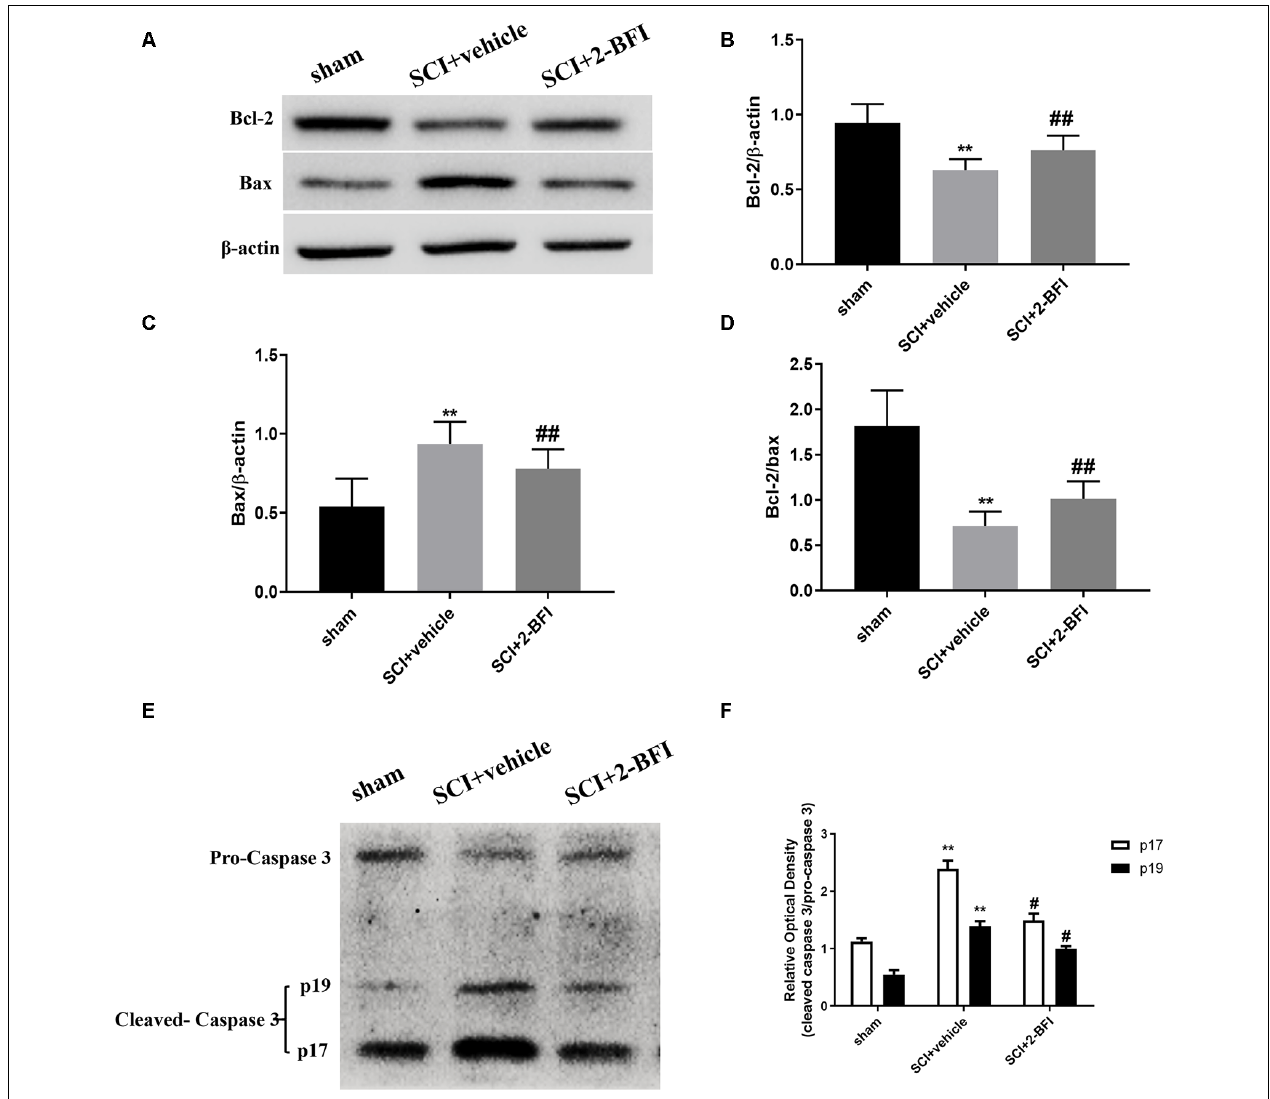
FIGURE 6 | The expression levels of the Bcl-2, BAX, and caspase-3 proteins were detected using Western blotting at 3 days after SCI (A,E) . Quantification of the Bcl-2 (B) , BAX (C) , the ratio of Bcl-2/Bax (D) and the ratio of cleaved-caspase 3 (p17, p19)/pro-caspase 3 (F) verified the antiapoptotic effect of 2-BFI. Band density was quantified using ImageJ software. n = 6 animals per group. Columns represent the mean ± SD. ∗∗ P < 0.01 vs. the sham group; ## P < 0.01 vs. the SCI+vehicle group; # P < 0.05 vs. the SCI+vehicle